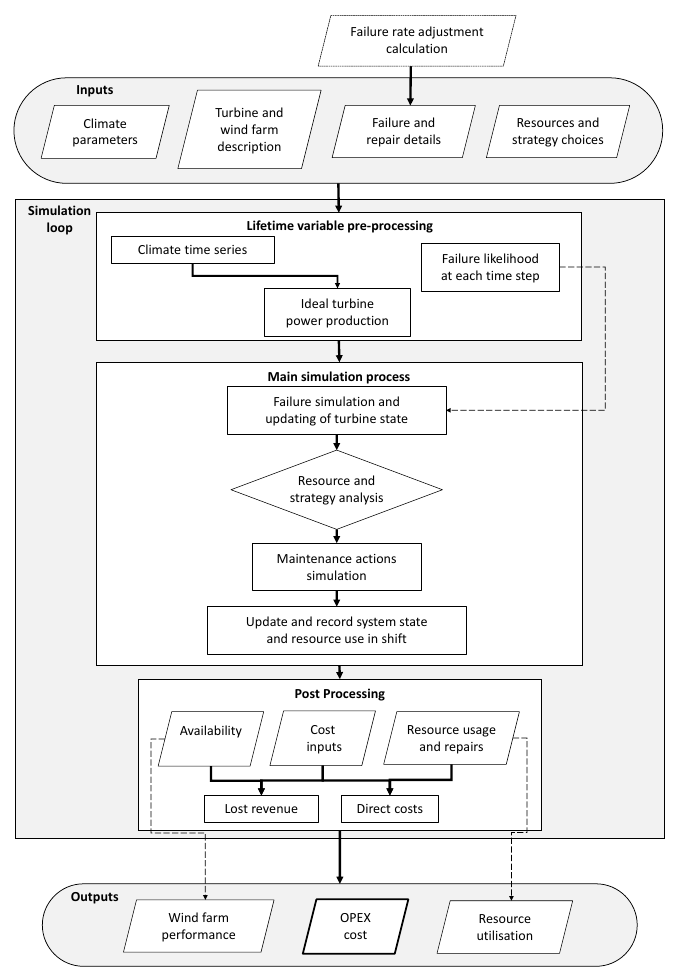
Figure 2. Simplified cost model structural overview, adapted from